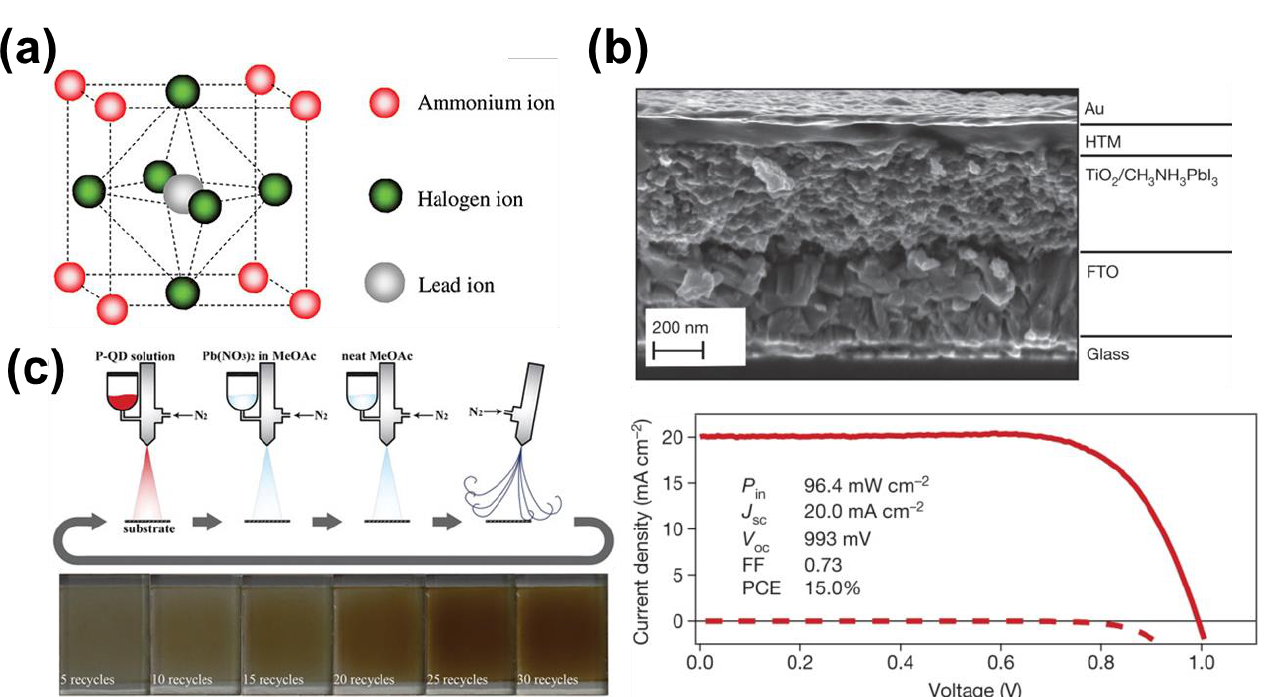
Figure 7. ( a ) Crystal structures of perovskite compounds [1]. Copyright 2009 American Chemical Society. ( b ) Cross-sectional SEM of a complete photovoltaic device [60]. Copyright 2013 Springer Nature. ( c ) Process of spray-coating deposition by the UFP method and photographs of NC thin films with different circulations [63]. Copyright 2019 John Wiley & Sons, Inc.